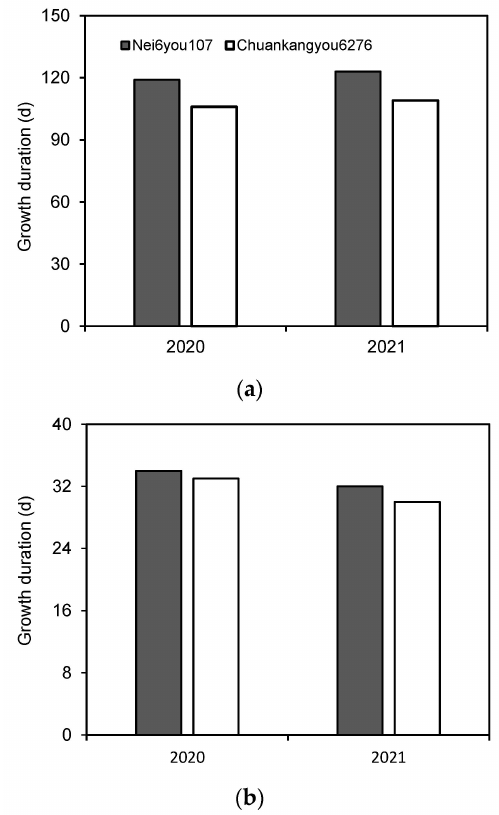
Figure 1. Growth duration of two hybrid rice varieties (‘Nei6you107’ and ‘Chuankangyou6276’) from sowing to heading ( a ) and from heading to maturity ( b ) in 2020 and